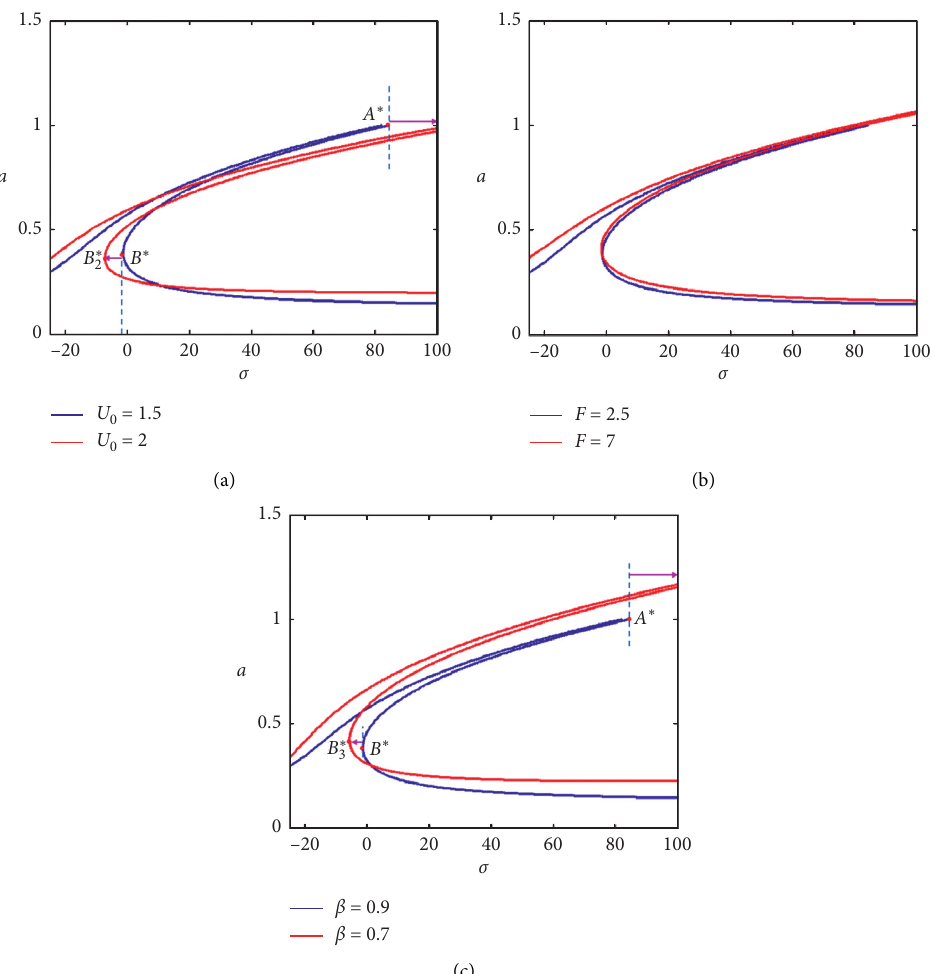
Figure 4: The amplitude-frequency response curves of the cantilevered pipe conveying pulsating fluid are obtained in the coupling case with different parameters. (a) Amplitude-frequency response curves when flow velocities U response curves when external forces F � 2 . 5 and F � 7 . 0, and (c) amplitude-frequency response curves when mass parameters β � 0 . 9 and β � 0 . 7.